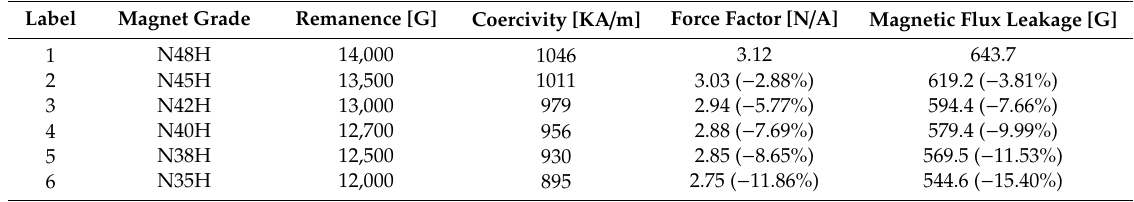
Table 2. Analysis results with different magnet grades.